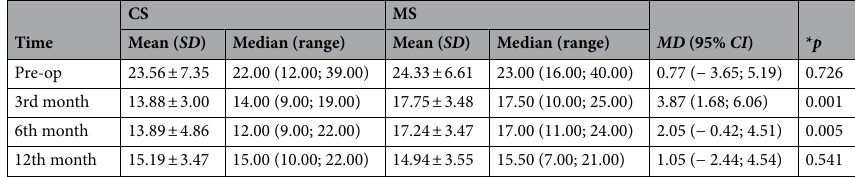
Table 2. Statistical characteristics of the IOP (means, medians, standard deviations, and ranges) in the CS and MS groups at specific timepoints post-surgery. CS corneal suture group, IOP intraocular pressure, MS muscle suture group, SD standard deviation, Pre-op pre-operatively, MD mean difference calculated as the result for the CS group minus the result for the MS group with the 95% confidence interval (CI). *Student’s t -test.